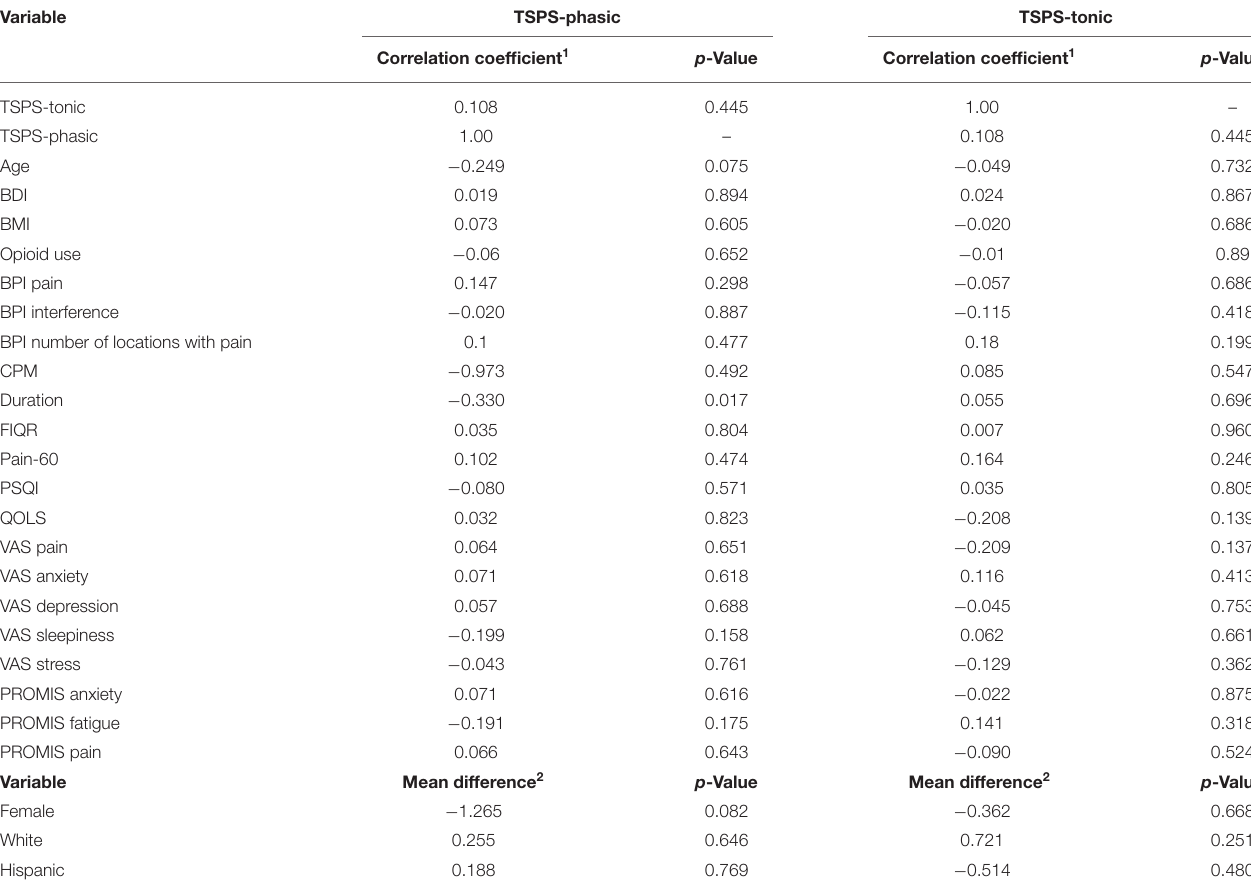
TABLE 3 | Univariable analysis of the association between TSPS-phasic and TSPS-tonic with other baseline characteristics.